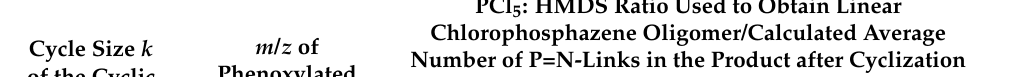
Figure 7. 31 P NMR spectra of linear oligophosphazene [Cl(PCl 2 =N) 7 PCl 3 ] + [PCl 6 ] − ( A ) and its cyclization product ( B ). Table 4. The composition of cyclic phopshazenes obtained by cyclization of linear